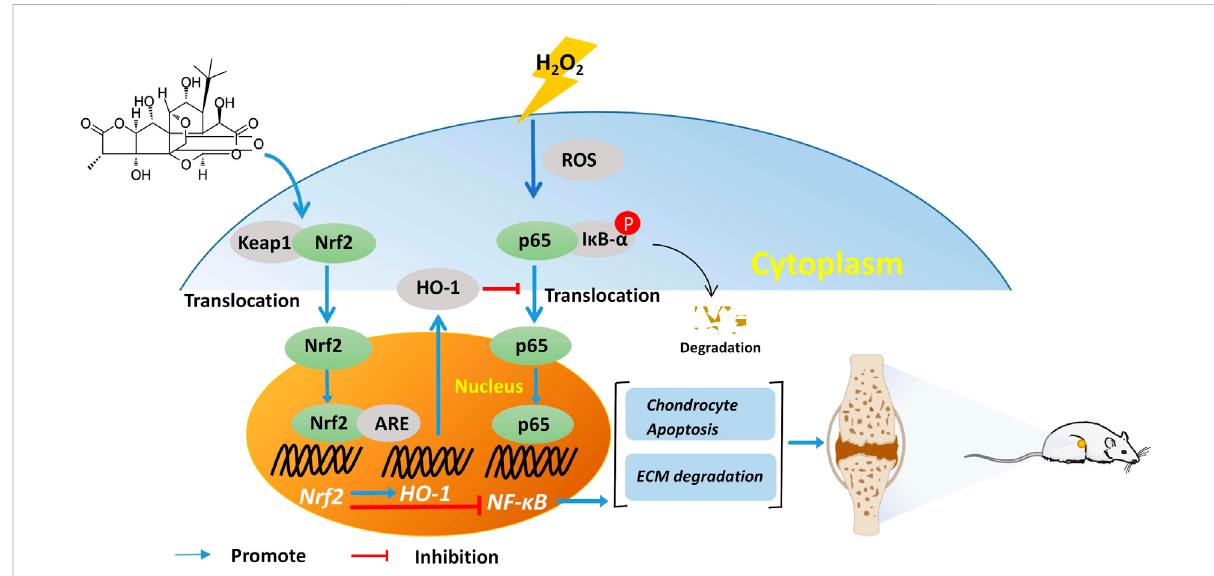
FIGURE 7 GC slows the progression of osteoarthritis by activating Nrf2/HO-1 and blocking the NF- κ B